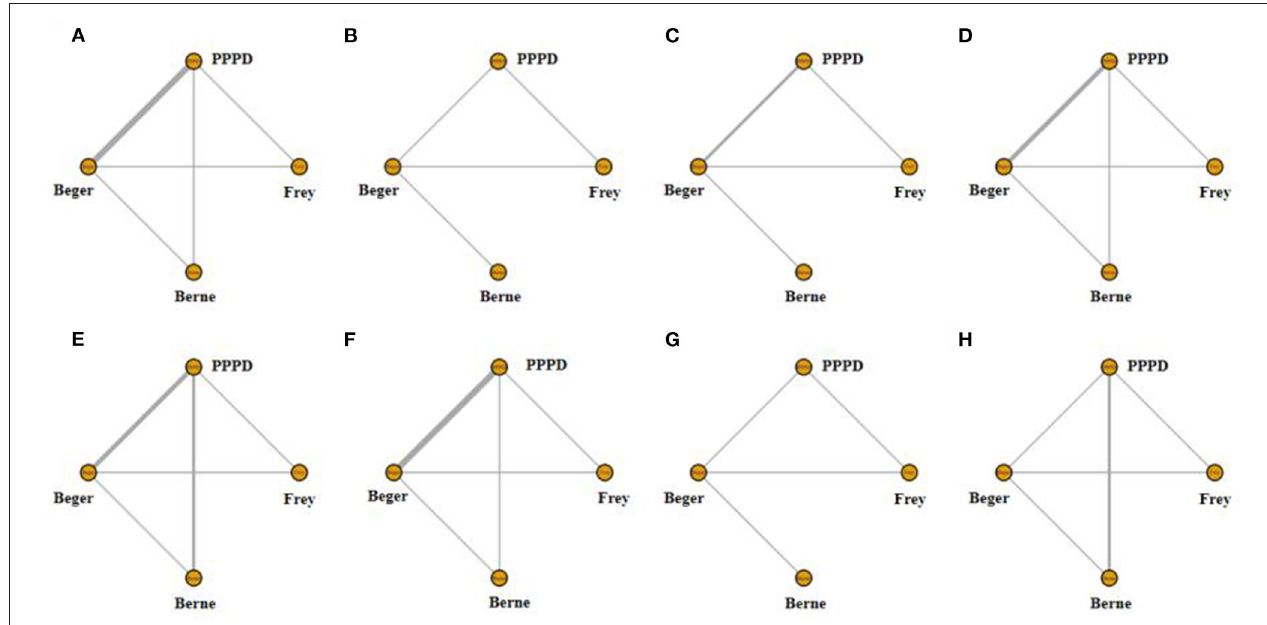
FIGURE 2 | Network of treatment comparisons. The width of the lines inflects the number of trials comparing each pair of treatments. (A) Network of short-term pain relief; (B) Network of long-term pain relief; (C) Network of quality of life; (D) Network of pancreatic exocrine function deficiency; (E) Network of pancreatic endocrine function deficiency; (F) Network of morbidity; (G) Network of long-term mortality; (H) Network of operation time. fibrosis and ductal hypertension (9, 44, 45); ductal hypertension may further exacerbate inflammation